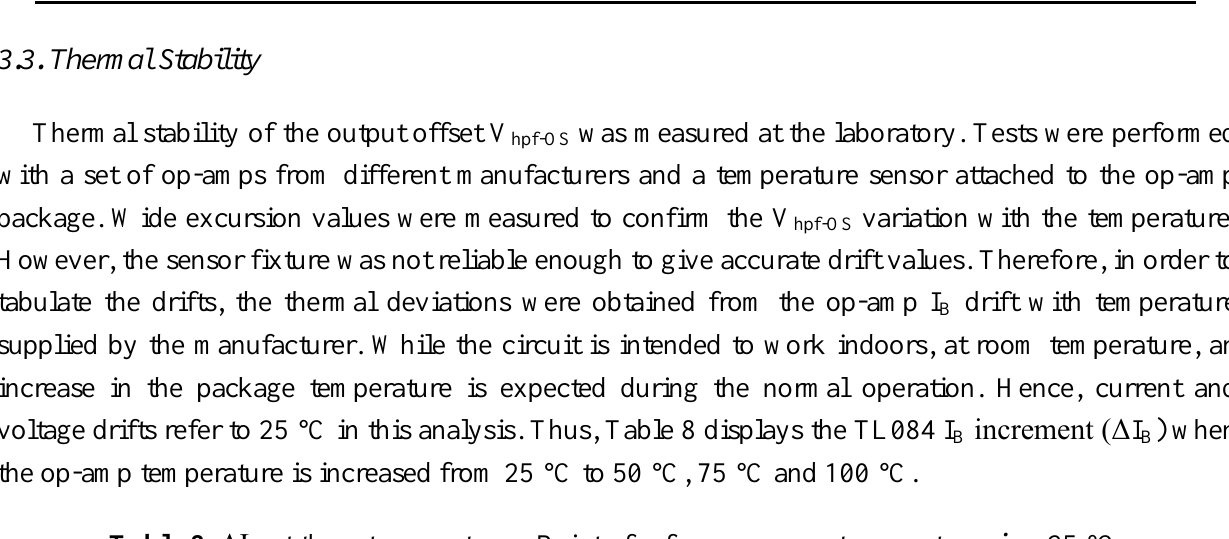
Table 8. ΔI at three temperatures. Point of reference, room temperature, i.e. , 25 B